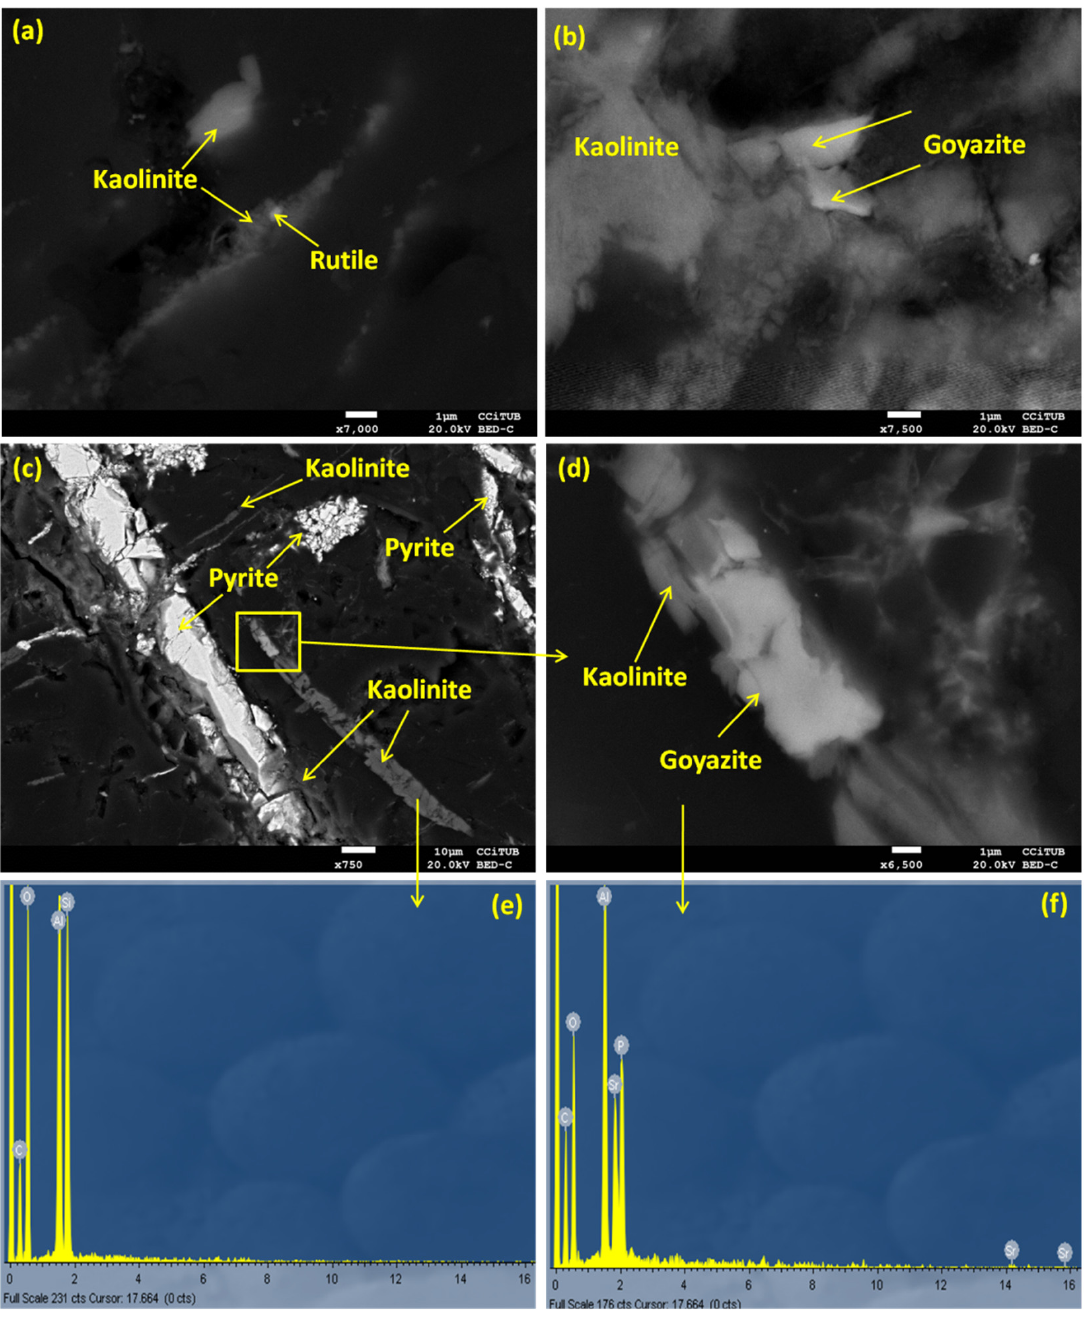
Figure 11. SEM back-scattered electron images of kaolinite, pyrite, rutile, and goyazitein the Jinhuashancoals. ( a ) Lens-like and banded kaolinite as fusinite cell infillings, coexisting with rutile; ( b ) Massive kaolinite and goyazite particles as cleat infillings; ( c ) Fracture / Cleat-infilling pyrite and kaolinite intergrown with goyazite; ( d ) Enlargement of yellow square in ( c ); ( e , f ) EDS spectrum respectively for kaolinite and goyazite in ( c ) and ( d ).